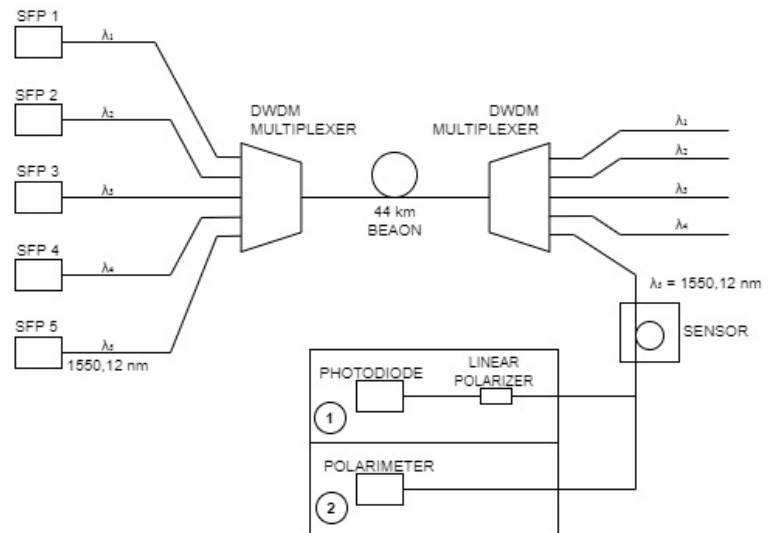
Figure 6. Arrangement for the measurements of the polarization properties of the passive DWDM systems. BEAON—Brno Experimental Academic Optical Network (the University of Defense to The University Hospital Brno to the Brno University of Technology). (1) and (2) are methods of meas- urement (Photodiode or Polarimeter).